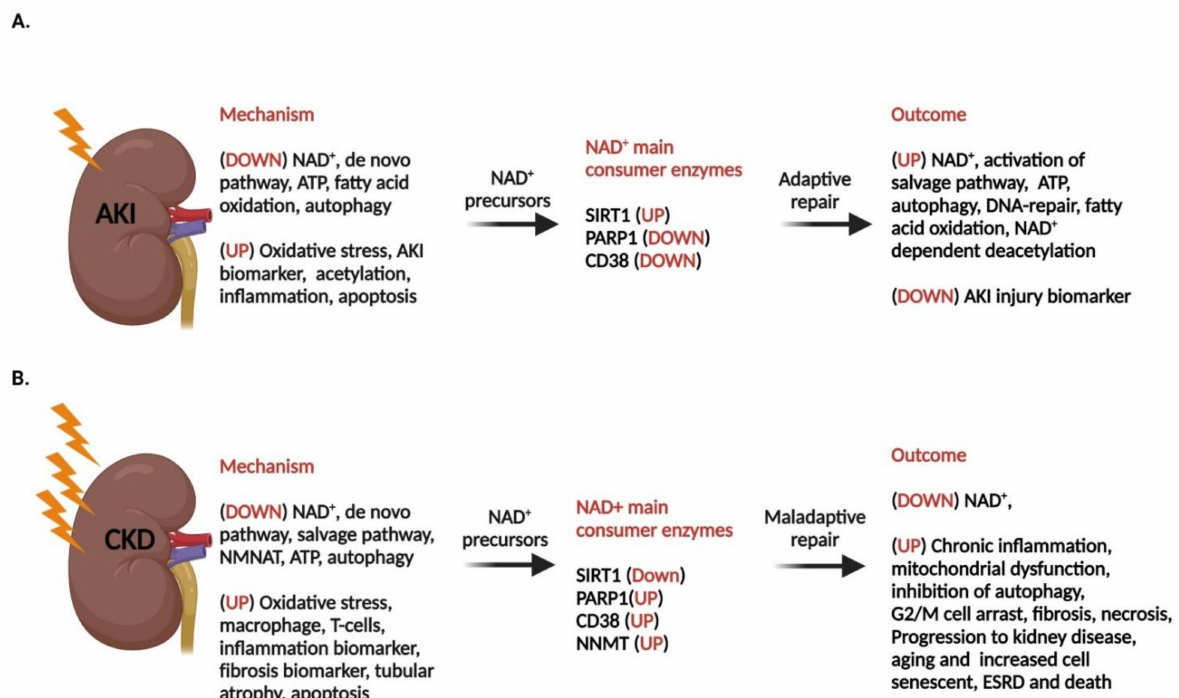
Figure 3. Compromised NAD + in response to AKI and CKD and augmentation with NAD +